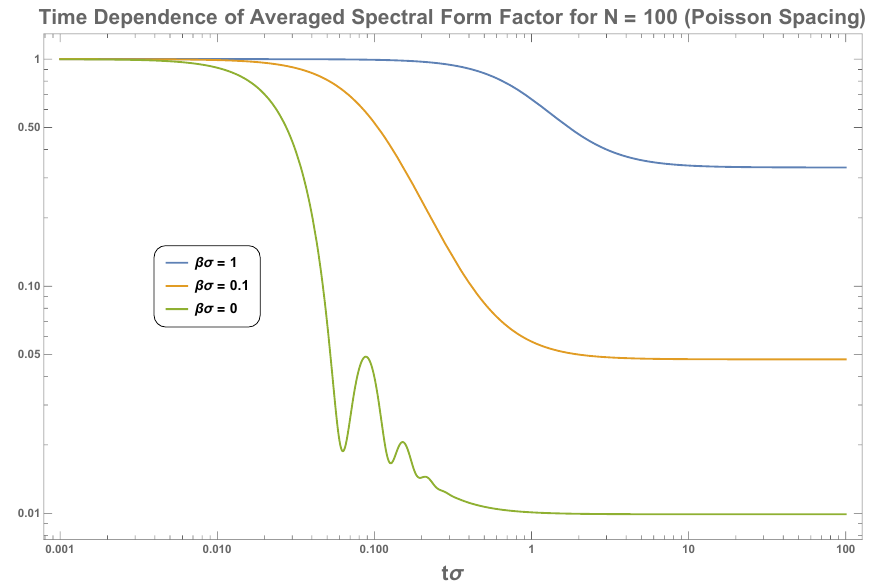
Figure 3 . Above is a Log-Log plot of the averaged spectral form factor of a spectrum generated by the i.i.d model with Poisson NNS distribution given by eq. (3.5). The value of N is fixed at N = 100 and the form factor is plotted for different temperatures ranging from βσ = 0 to βσ = 1